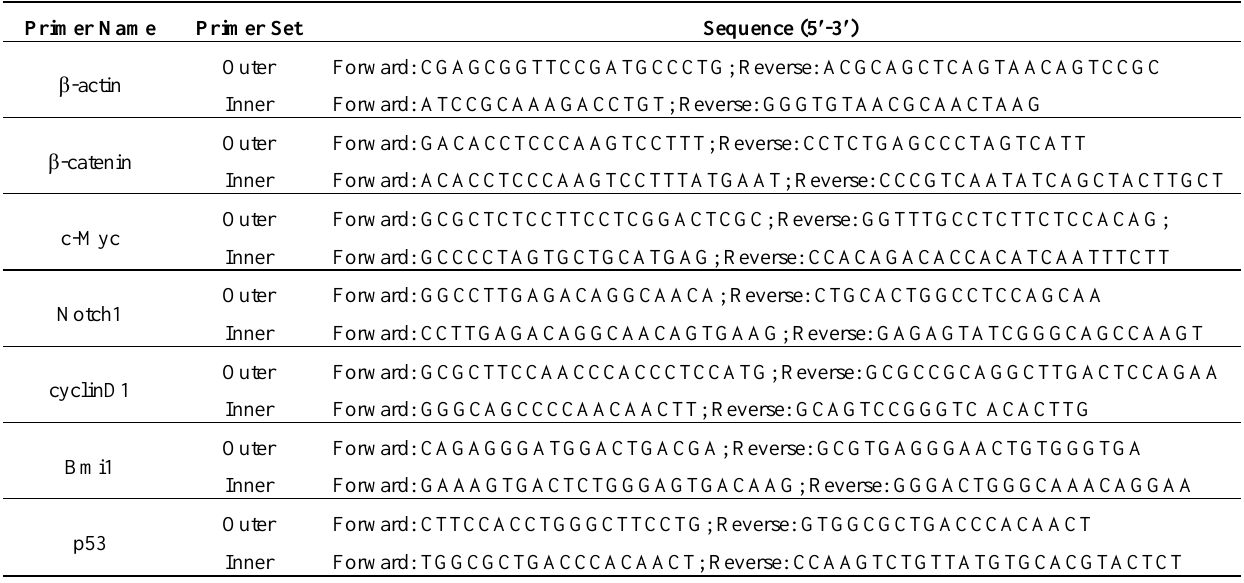
Table 1. All outer (or nesting) primer pairs and the Real time-PCR primers used in this